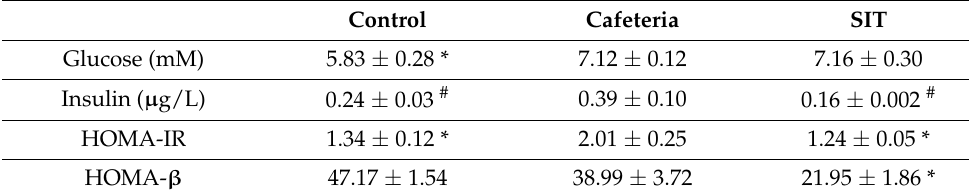
Table 4. Fasting plasma samples obtained at week 14 of the rats treated with GSPE simultaneously to a cafeteria diet